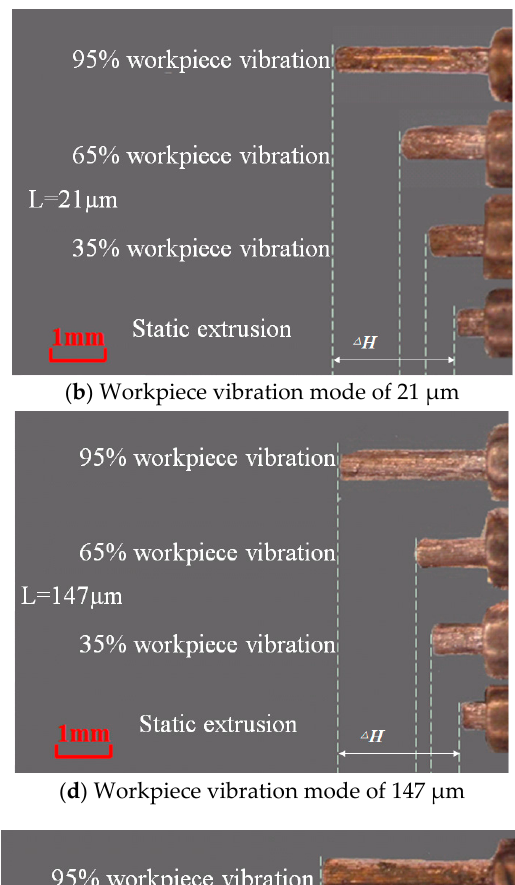
Figure 6. Micro-extrusion stress with different power output and different vibration modes for different grain sizes.